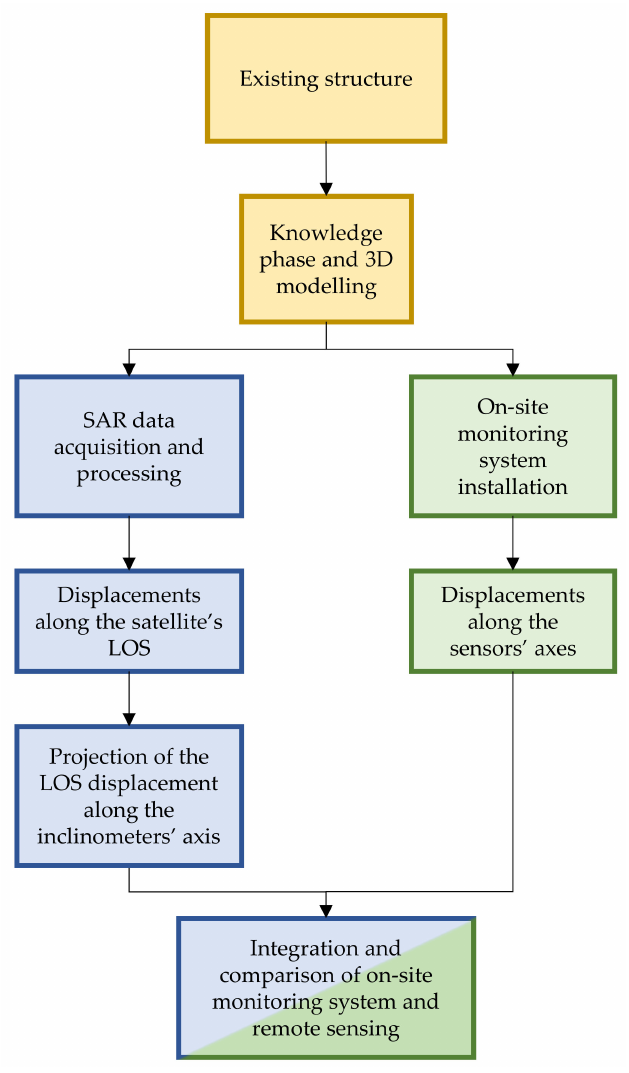
Figure 1. Workflow of the followed